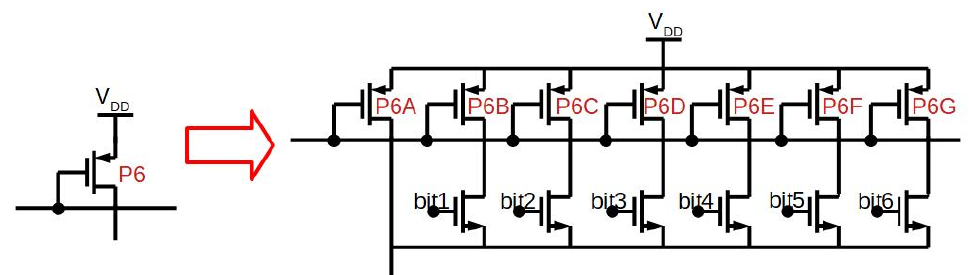
Figure 12. Trimming circuit. Table 4. Transistor dimensions of the trimming circuit.